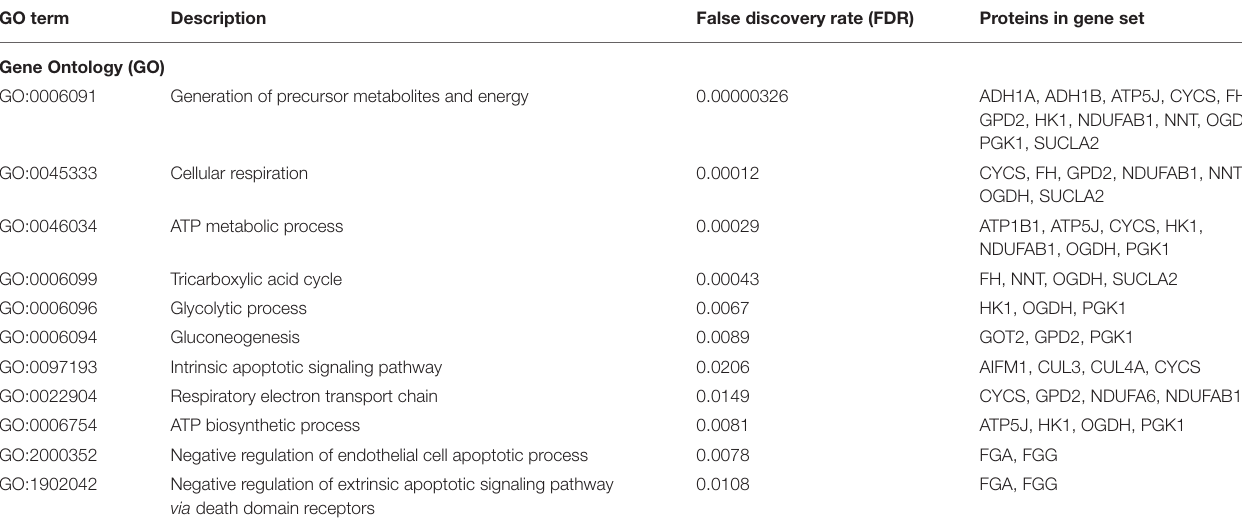
TABLE 2 | Enriched functional categories involving cellular energy processes and apoptotic signaling pathways.